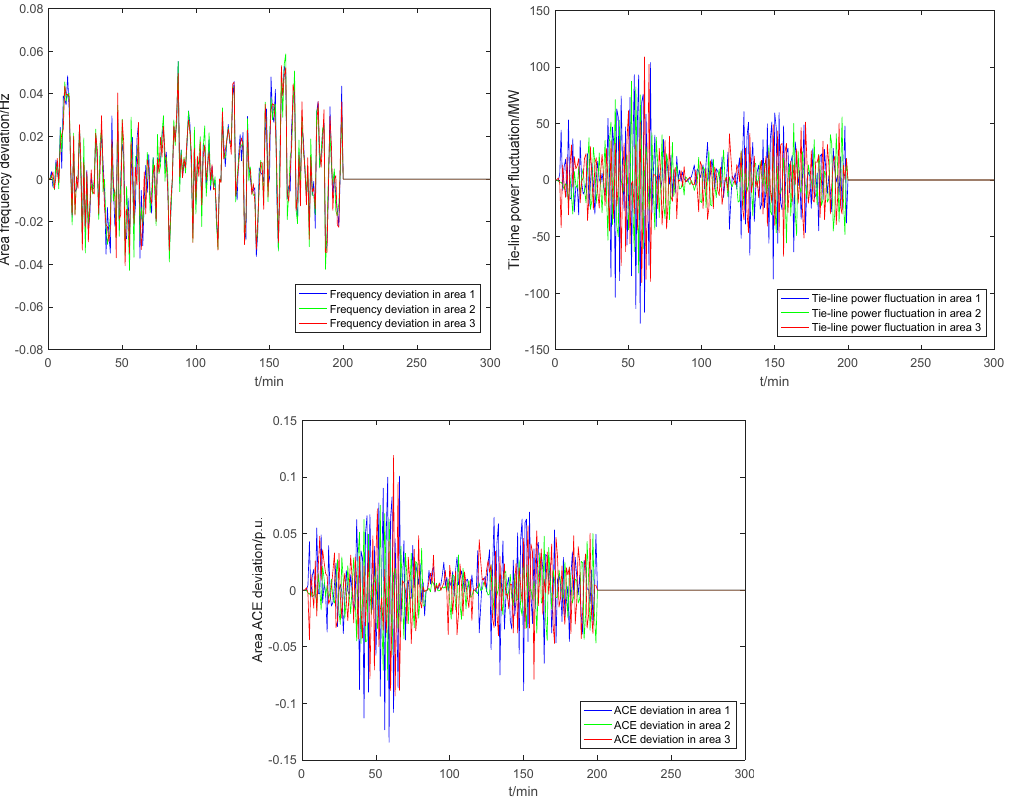
Figure 7. Area main state variables and output variables curves.